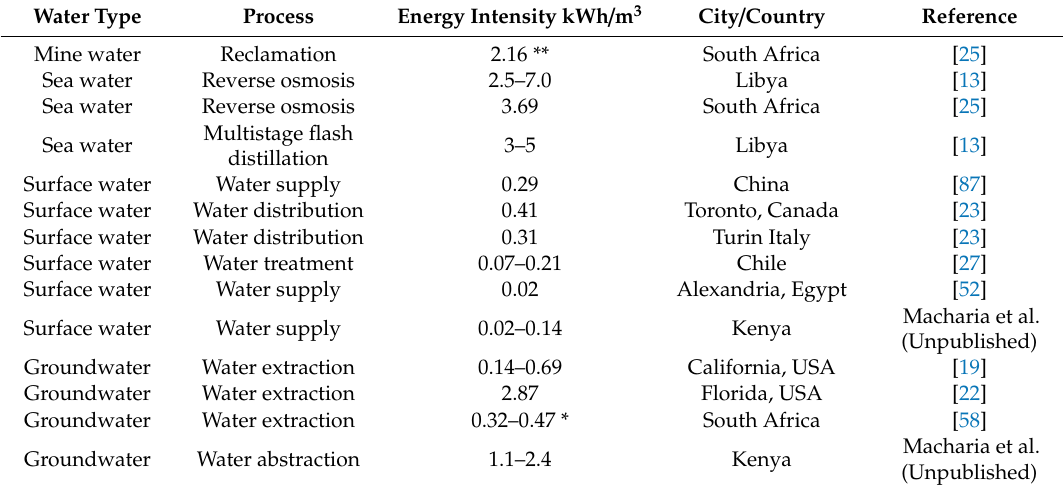
Table 4. A summary of studies on energy use for drinking water supply